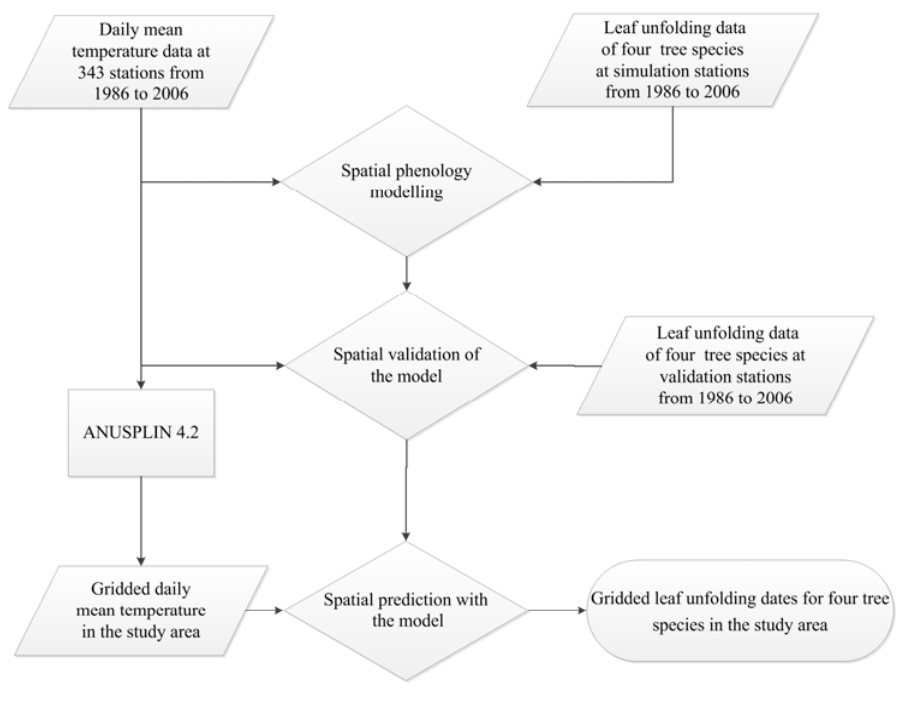
Figure 3. Flow-diagram of daily mean temperature-based spatial LU simulation and